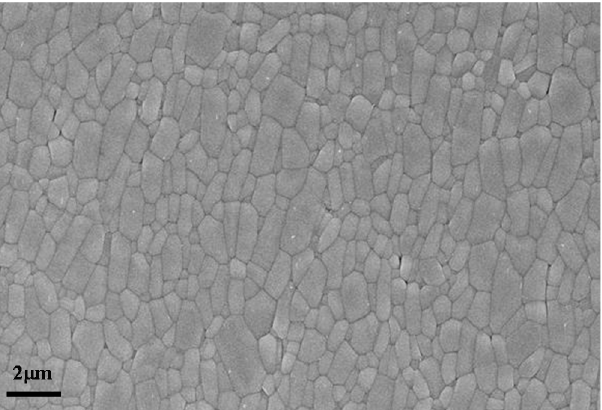
Figure 10. The SEM of the La 0.3 Sr 0.7 Fe 11.4 O 19 sintered magnet with additive CaCO 3 = 0.7 wt%, SiO 2 = 0.25 wt% and Co 3 O 4 = 1.7 wt% added after calcination.